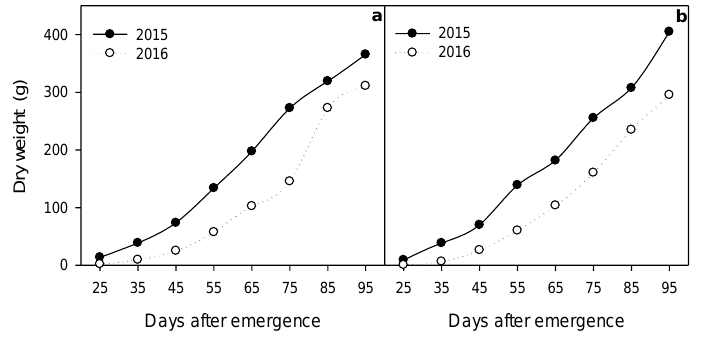
Figure 2. Accumulation of dry biomass recorded during the development of the cucumber crops Vitaly ( a ) and Luxell ( b ) varieties. The data are the average of four plants.